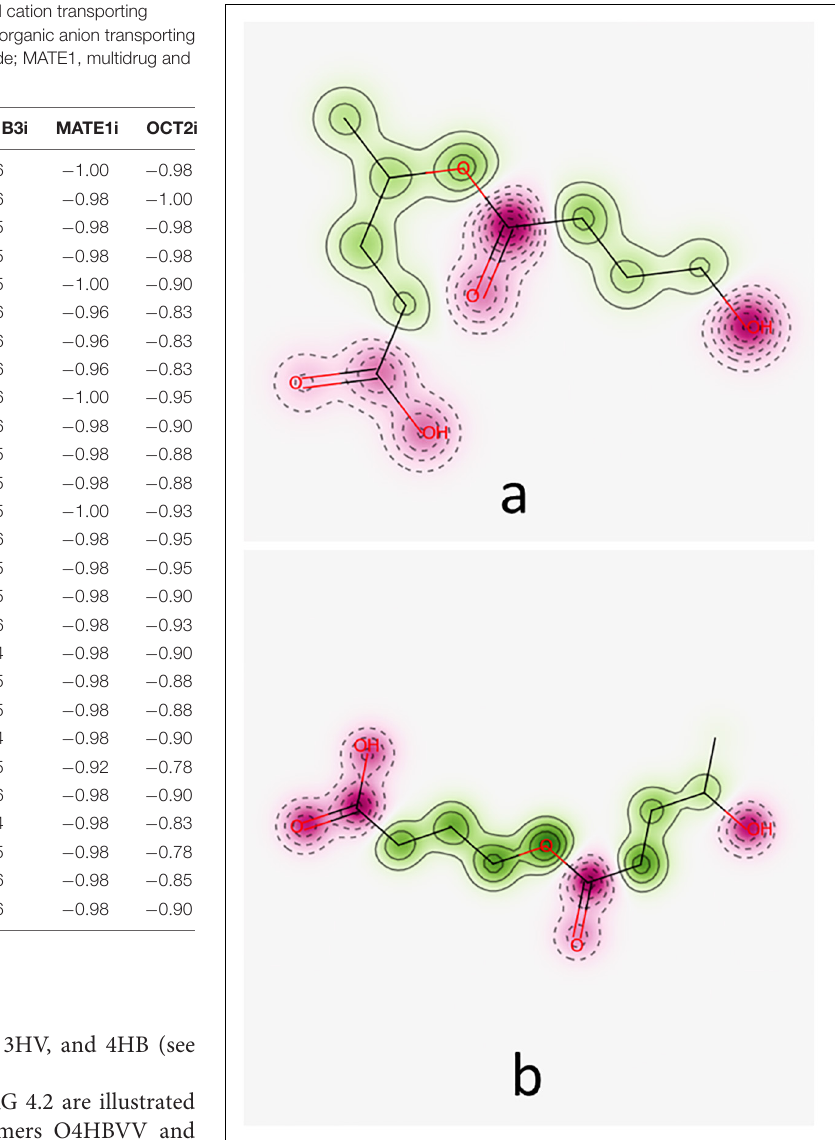
FIGURE 4 | Probability maps illustrating the contribution of fragments of co -oligomers O4HBV (a) and O4HVB (b) toward hERG K + channel blockage. Fragments in green represent contributions toward blockage of hERG, pink fragments contribute to a decrease of hERG